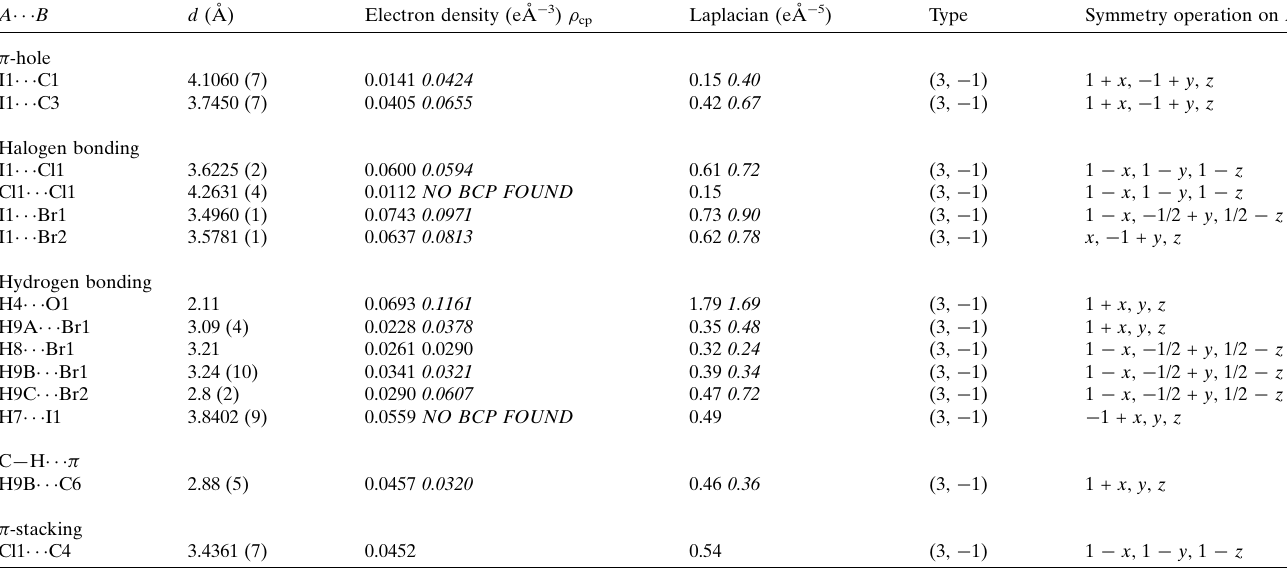
Table 3 Experimental and calculated (italic) intermolecular bonding critical points in the crystal structure of 1 . A (cid:2)(cid:2)(cid:2) B